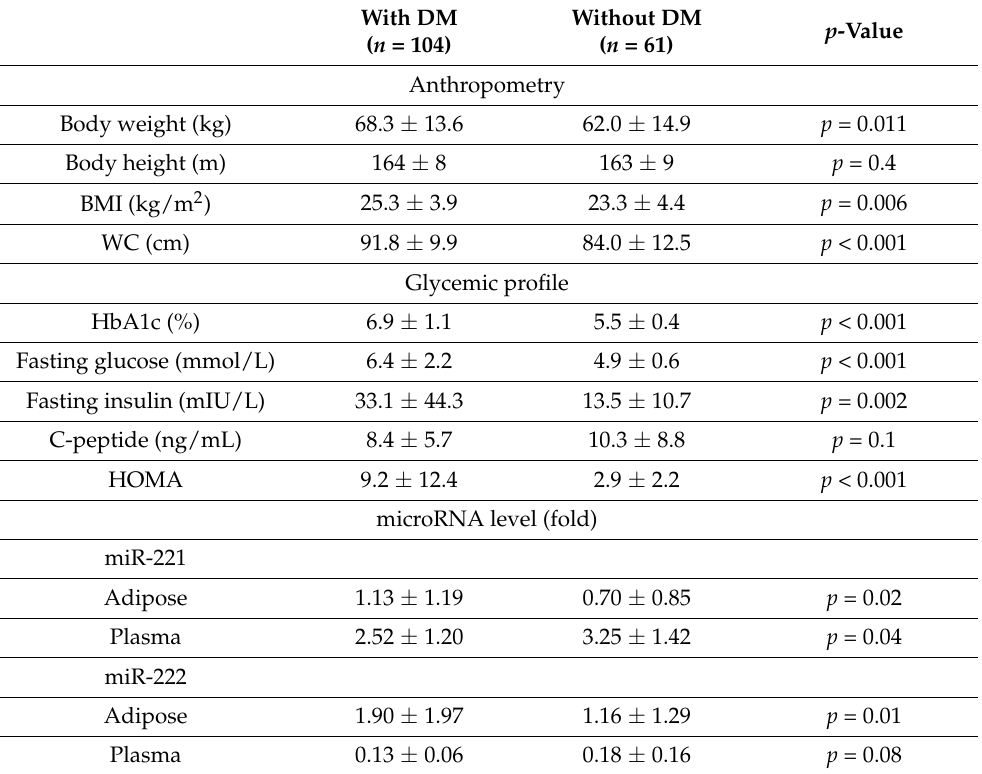
Table 2. Anthropometry, glycemic, and miRNA profile at baseline.